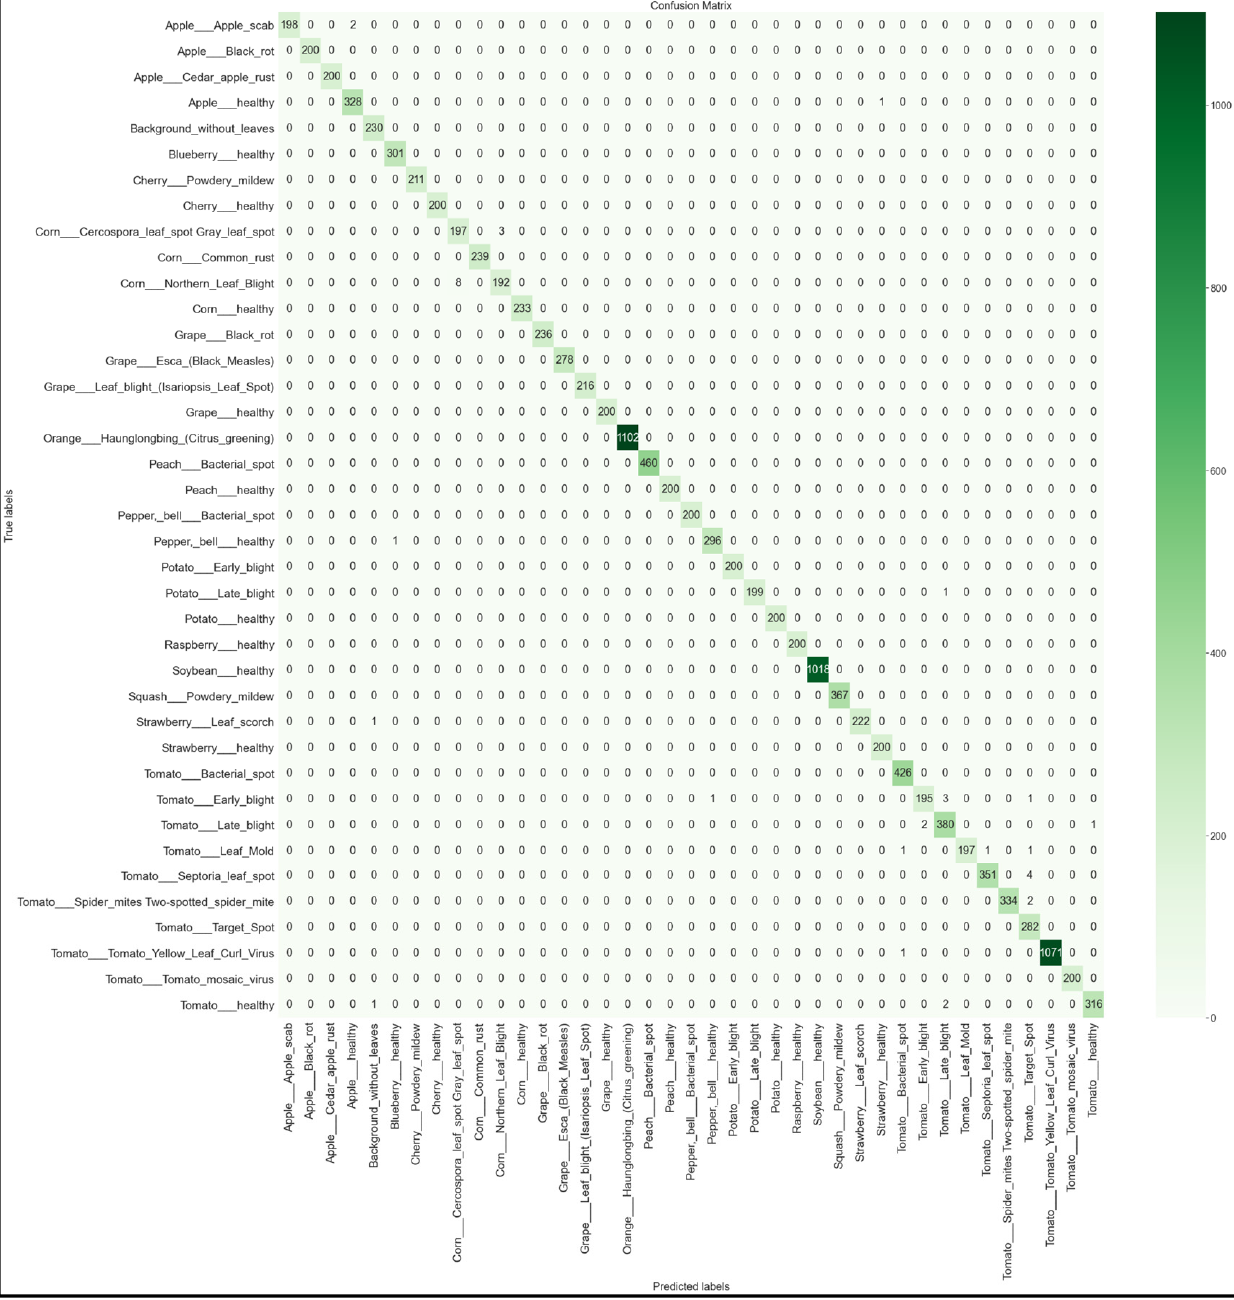
Figure 19. 39 × 39 Confusion matrix for the EfficientNetB0 model with transfer learning Scenario 4 and the Proposed hyperparameters.